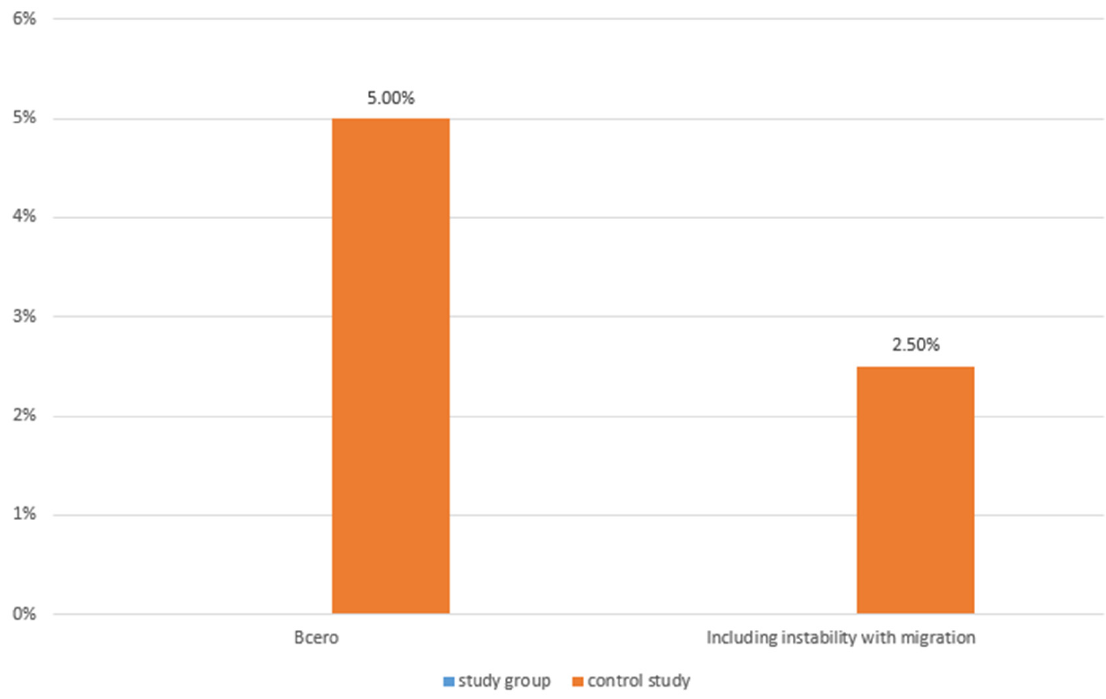
Figure 3. Proportion of patients with screw instability and cage migration (%).